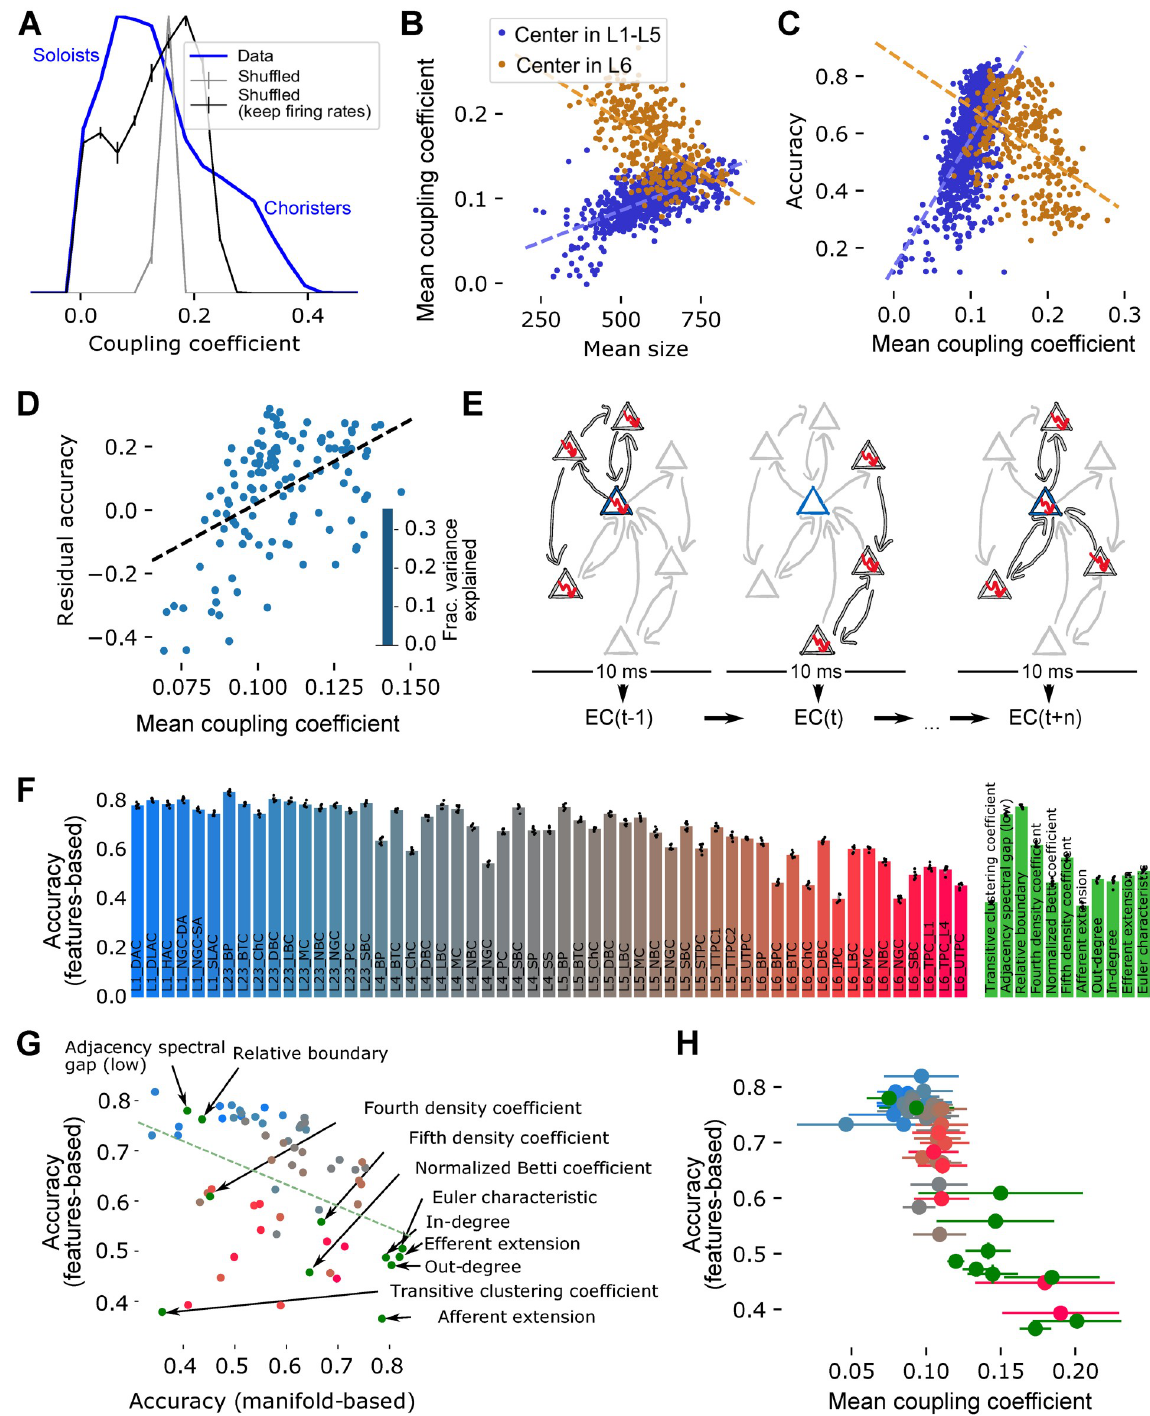
Fig 6. Coupling coefficient and topological featurization. A: Distribution of the coupling coefficient , as in Okun et al., 2015, of all excitatory neurons in the model. Blue: data; grey lines with errorbars: Shuffled controls that keep or shuffle mean firing rates of individual neurons. Neurons with an unexpected low coefficient are “soloists”, a high coefficient indicates a “chorister”. B: Neighborhood size against the coupling coefficient of the center for center neurons in layers 1–5 (blue) and in layer 6 (orange). Dashed lines: linear fits. C: As in B, but coupling coefficient against classification accuracy of the neighborhoods. D: Mean coupling coefficient of neurons in a volumetric sample against its residual classification accuracy, as in Fig 5C. Inset: Fraction of variance explained as in Fig 5D. E: Classification based on topological